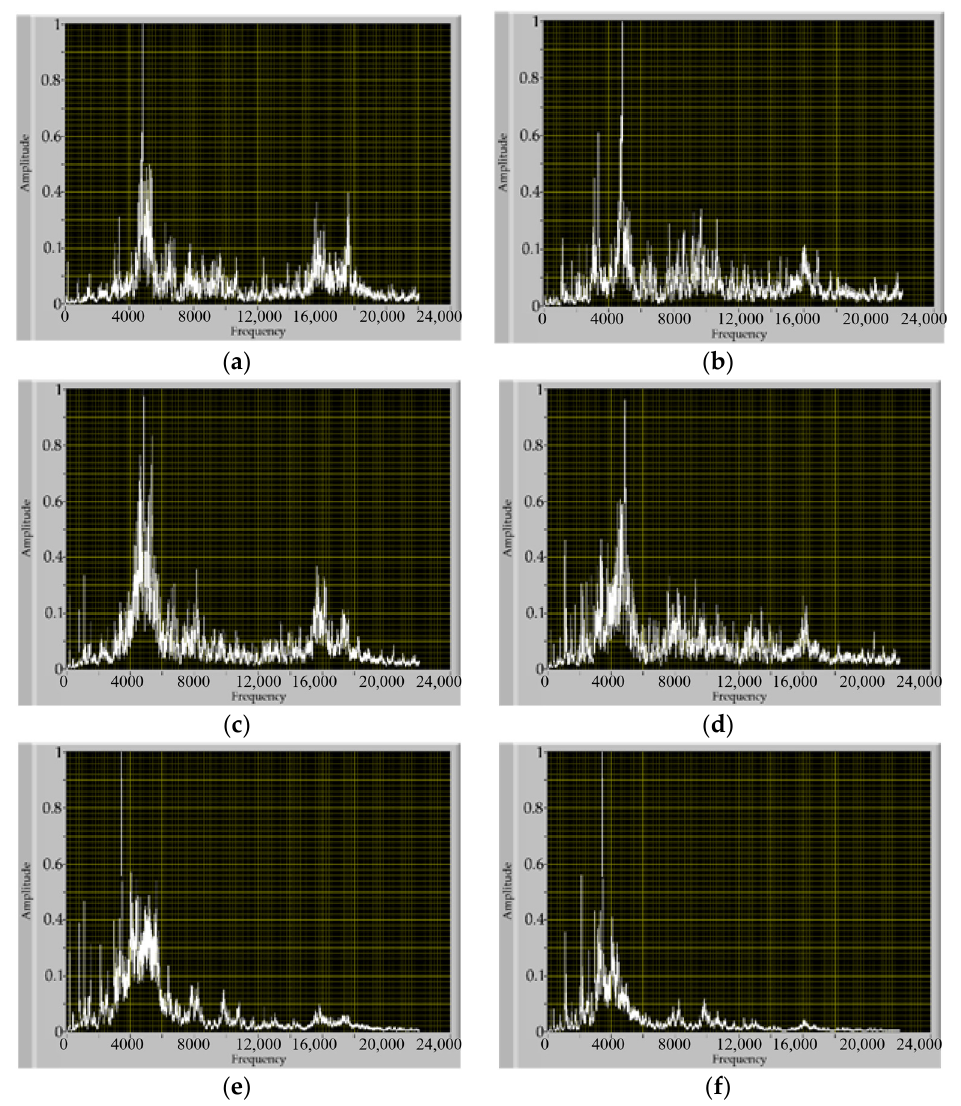
Figure 4. Oscillation spectra of a defect-free pipeline: ( a ) signal along the X-axis at a pressure of 4 atm; ( b ) signal along the Y-axis at a pressure of 4 atm; ( c ) signal along the X-axis at a pressure of 3 atm; ( d ) signal along the Y-axis at a pressure of 3 atm; ( e ) signal along the X-axis at a pressure of 2 atm; ( f ) signal along the Y-axis at a pressure of 2 atm.